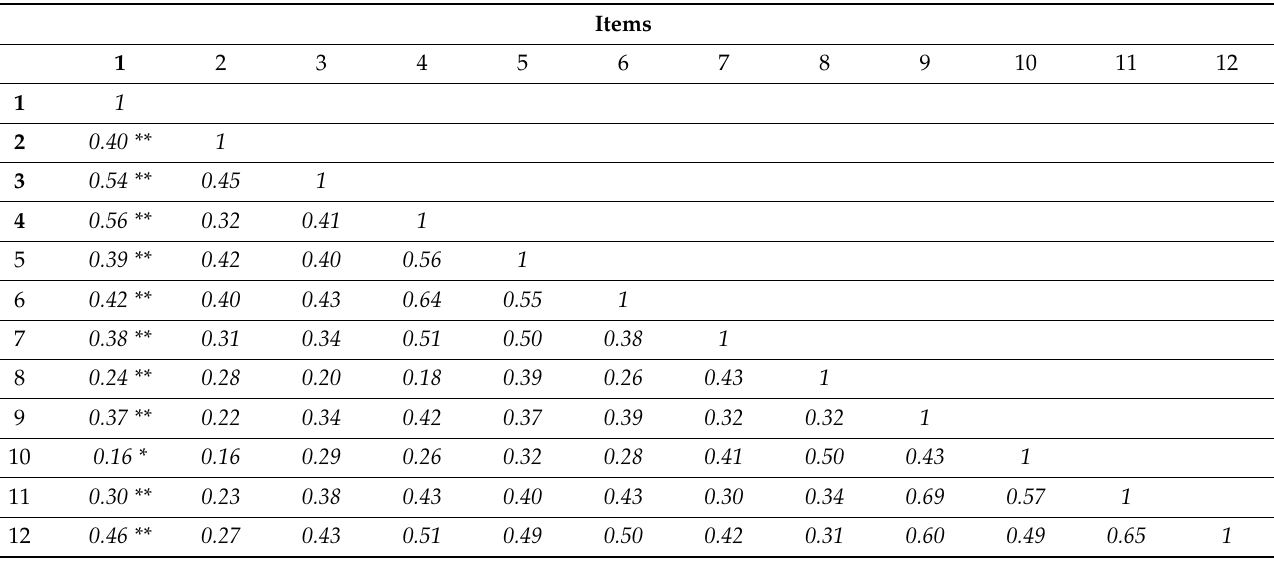
Table 2. Convergent validity (interitem Pearson’s r correlations) of the Portuguese version of MISS. Items